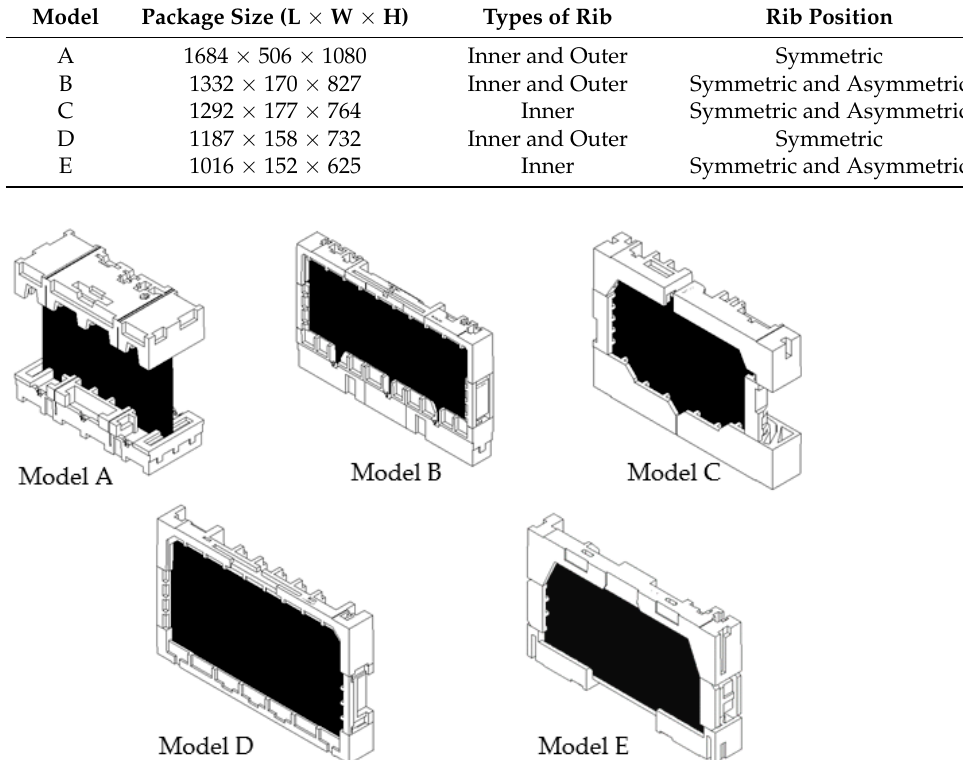
Figure 3. Molded EPS packaging design models.